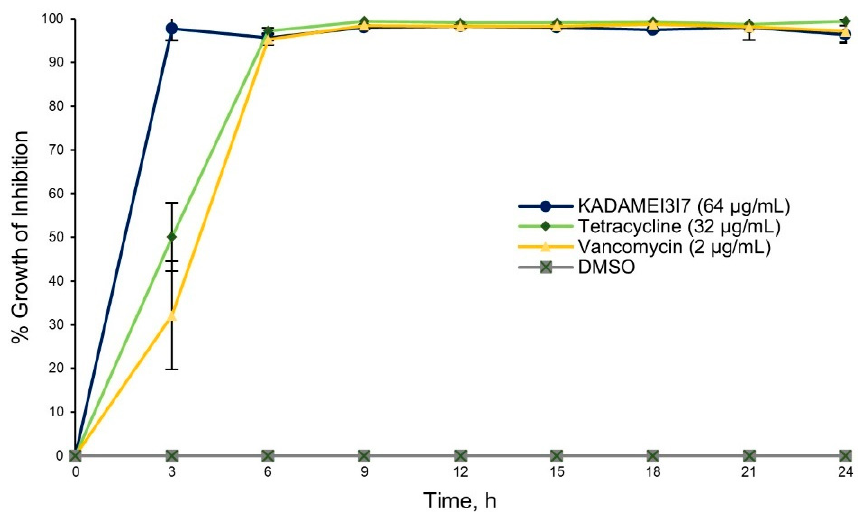
Figure 4. Antibiotic kinetics assay against MDRSA. The data illustrated are the % growth inhibition ( ± SD) of KADAMEI3I7 (64 µ g/mL), tetracycline (32 µ g/mL, positive control), vancomycin (2 µ g/mL, positive control), and DMSO against S. aureus ATCC BAA ‐ 44 at different time interval. Bacterial density was measured every 3 h from 0 to 24 h. Assay was conducted in triplicates. Error bars rep ‐ resent the standard deviation.